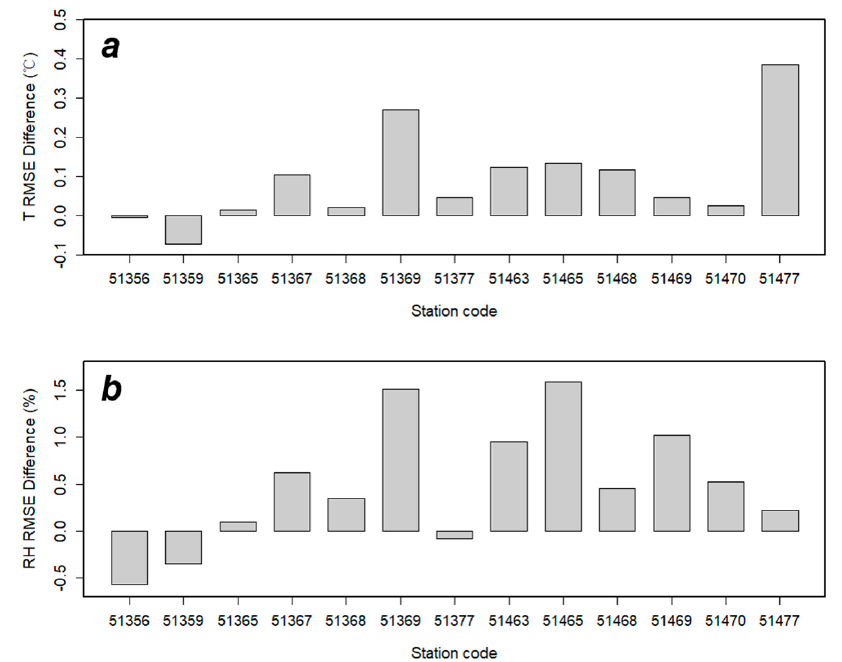
Figure 9. Difference between the RMSE values of post-correction forecasts for: ( a ) temperature and ( b ) relative humidity by AutoML model and traditional linear MOS method.